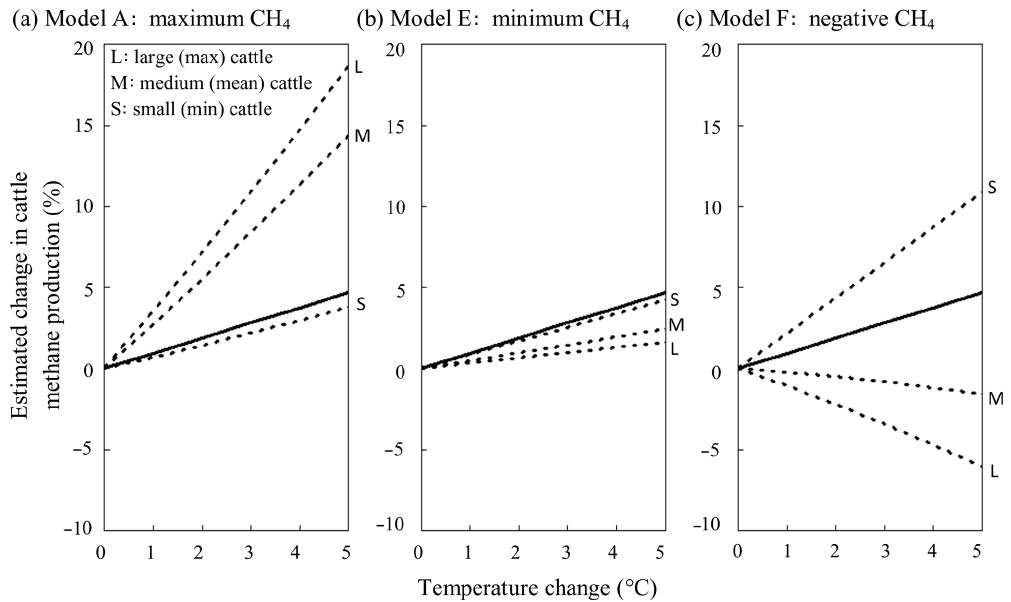
Figure 4. The estimated change in enteric methane production with temperature change for (a) the model predicting the largest increases in methane production (maximum CH 4 ) , (b) the model predicting the lowest increases in methane production (minimum CH 4 ) and (c) the model which predicts both increases and decreases in methane production (negative CH 4 ) . The dotted lines represent the predictions for minimum sized (small, S), mean sized (medium, M) and maximum sized (large, L) cattle. S, M and L cattle were defined as cattle consuming 9.7, 18.8 and 28.9kg DMId − 1 , respectively, for models A and E. S, M and L cattle were defined as consuming 1.4, 7.7 and 10kg DMId − 1 , respectively, for model F, which represents less productive tropical regions. Values do not include projected changes to the global cattle inventory. The continuous lines represents the mean weighted